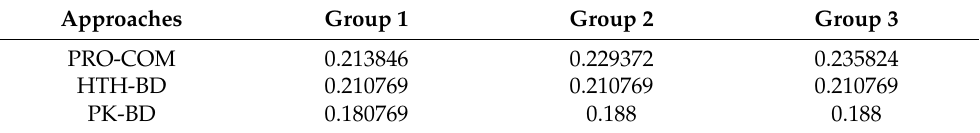
Table 22. The MSE considering the three approaches and the three groups of products evaluated (Second survey).